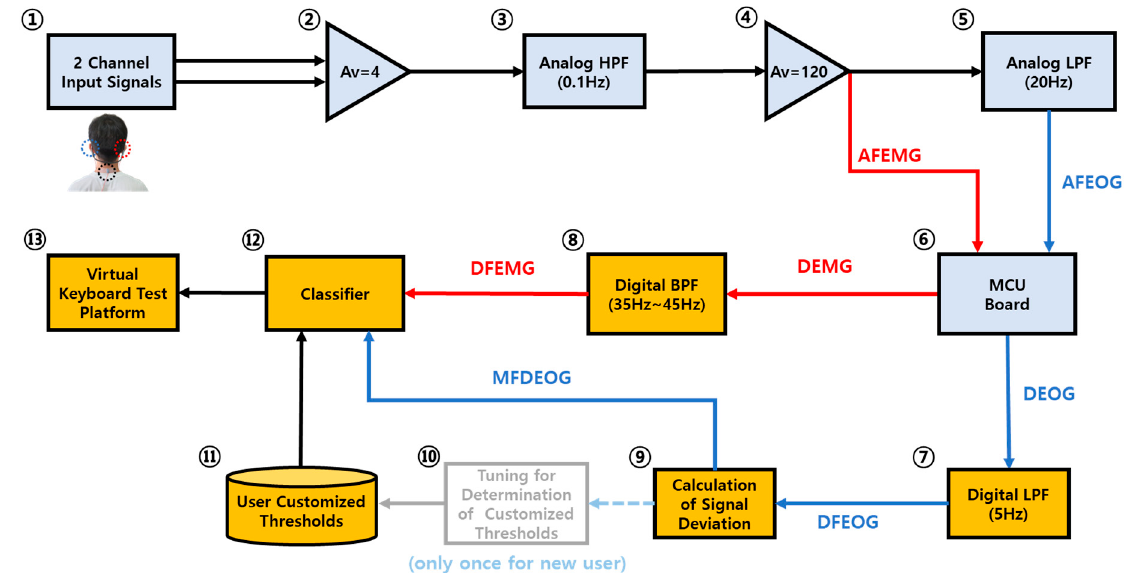
Figure 2. Block diagram of EOG and EMG-based interface system.